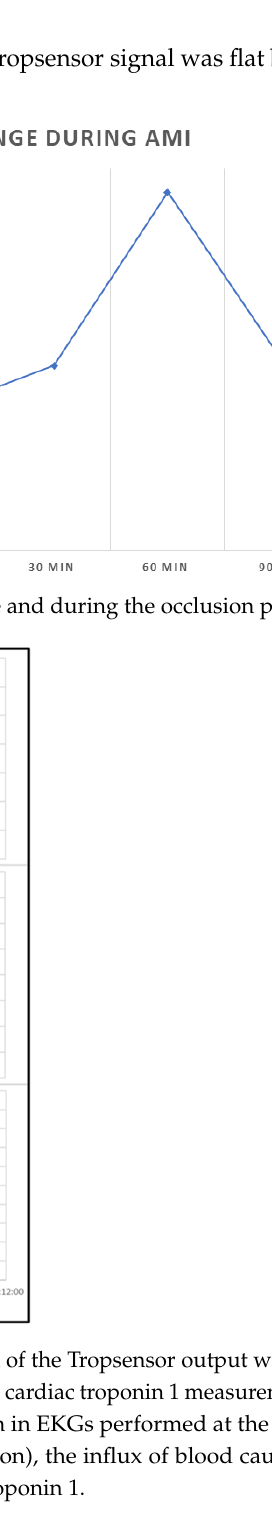
Figure 4. Real-time temporal correlation of the Tropsensor output with ELISA-based high sensitiv- ity cardiac troponin 1 and IDEXX traditional cardiac troponin 1 measurements. The presence of infarction was confirmed by ST-segment elevation in EKGs performed at the set time points. When the LAD occlusion was resolved (balloon deflation), the influx of blood caused an increase in the troponin reading in all methods. cTn1, cardiac troponin 1.